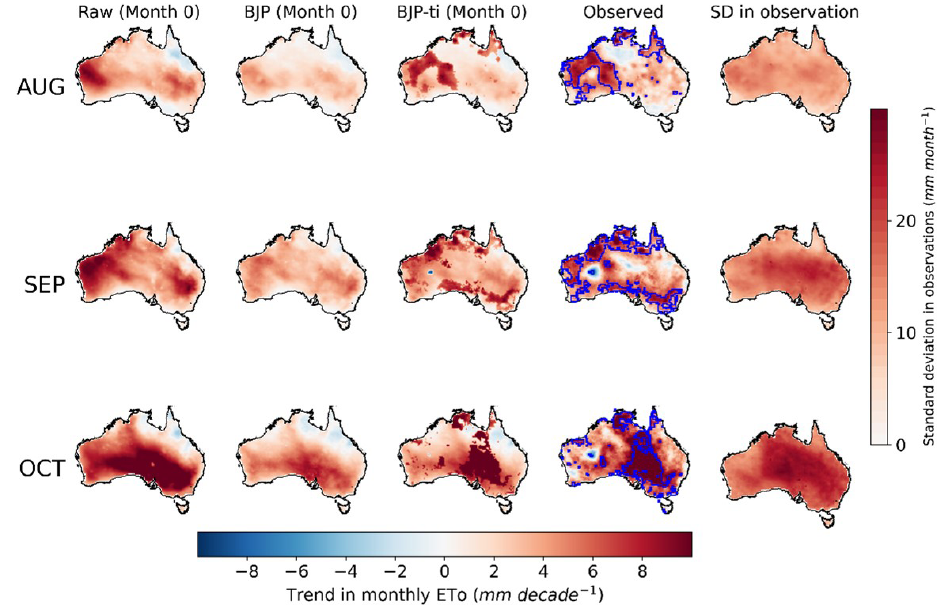
Figure 1. Trends in raw forecasts, BJP calibrated forecasts, and BJP-ti calibrated forecasts at month 0 and observed ET o in August, Septem- ber, and October. Blue polygons show regions where observed trends are statistically significant. SD refers to the standard